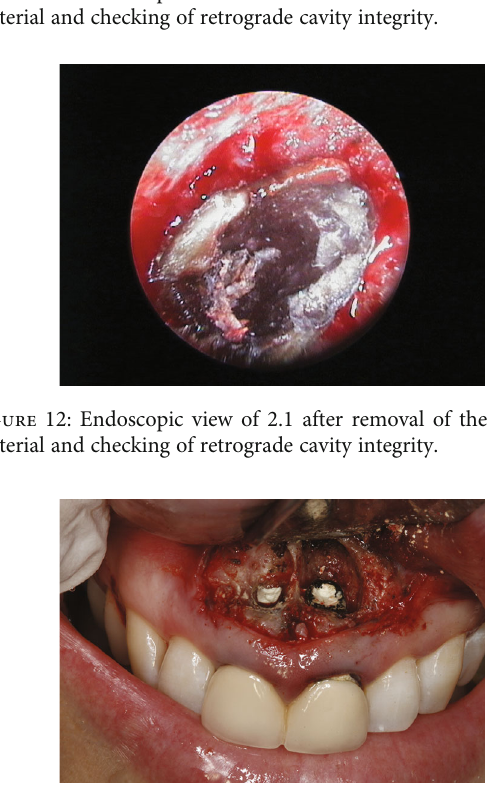
Figure 13: Clinical view of fi lling with MTA of the retrograde cavities of 1.1 and 2.1.